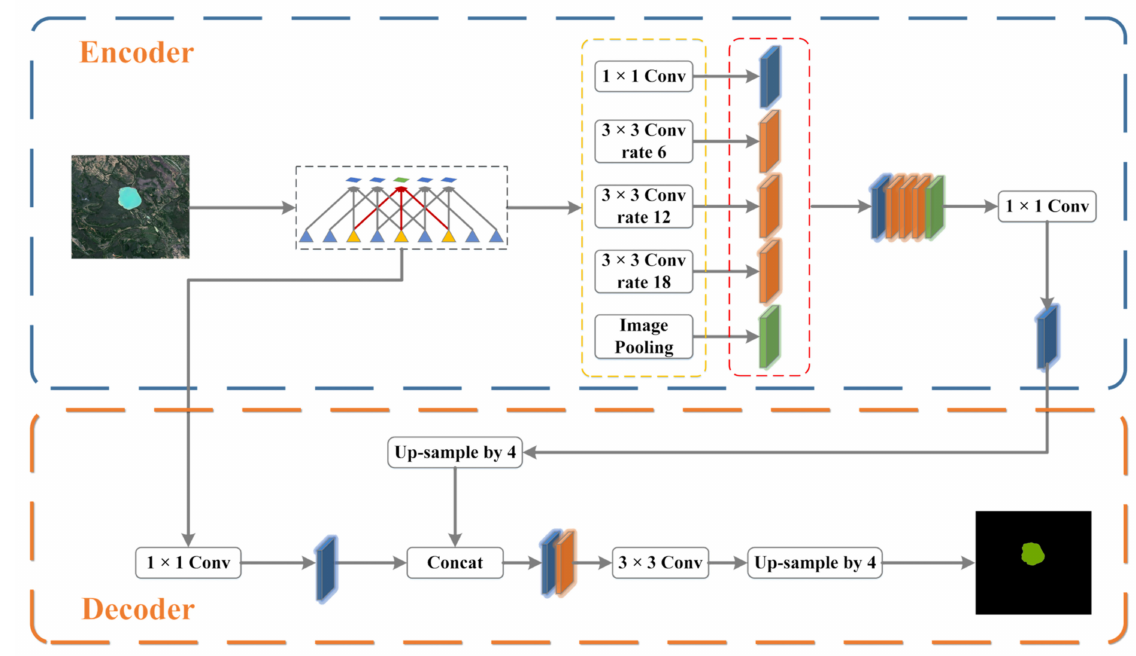
Figure 2. DeepLab V3+ network generalization diagram.